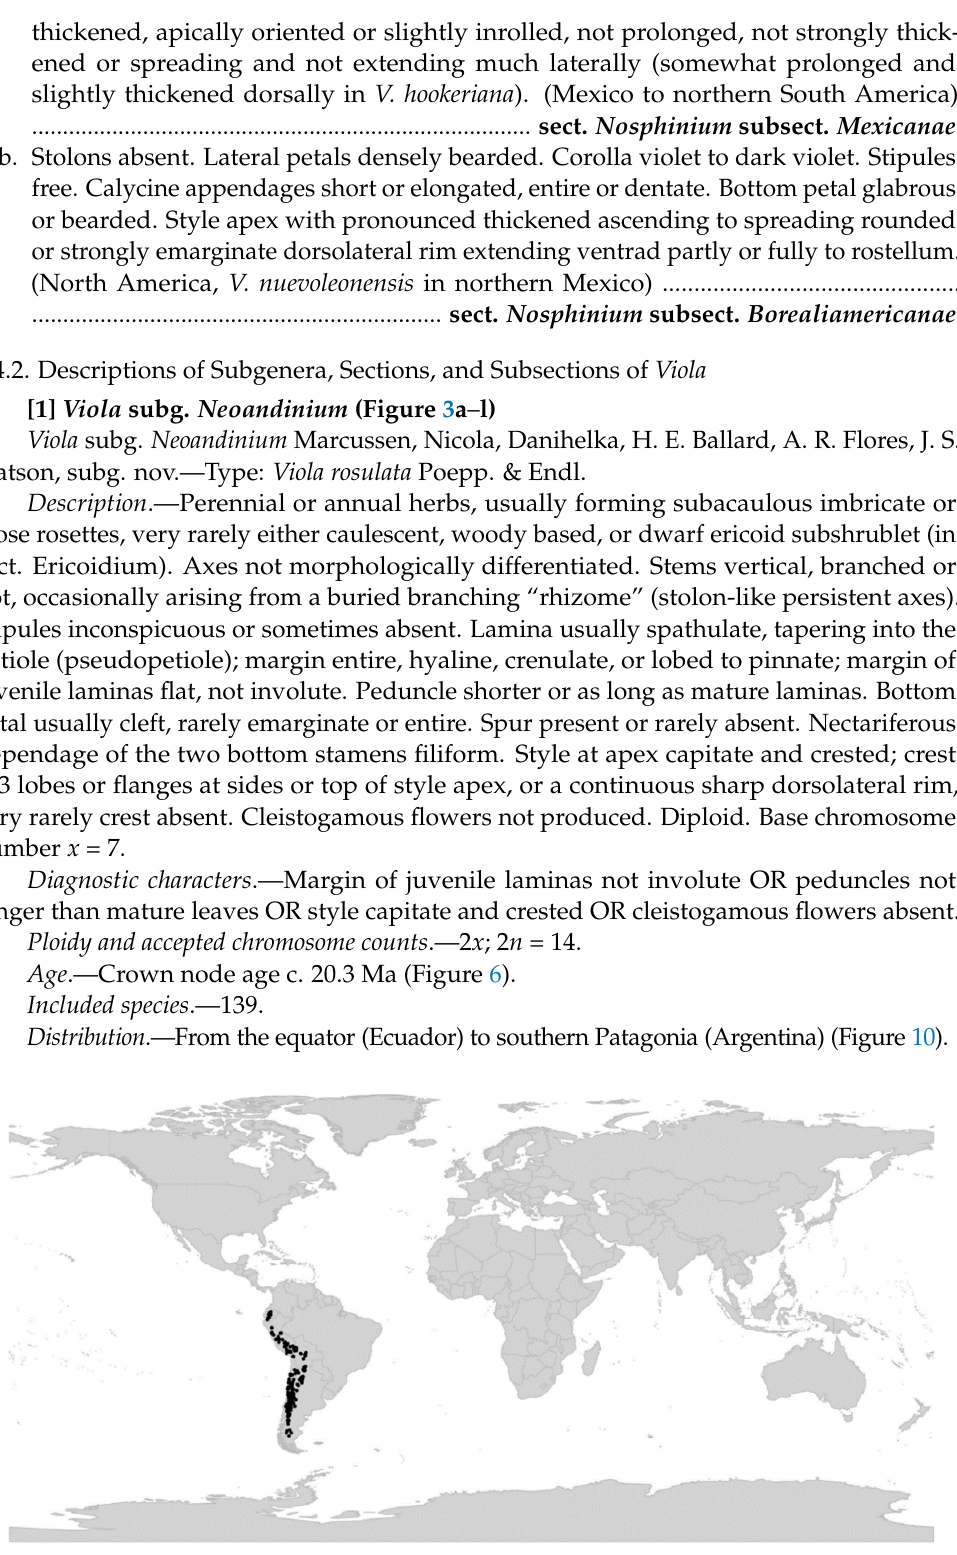
Figure 10. Global distribution of Viola subg. Neoandinium